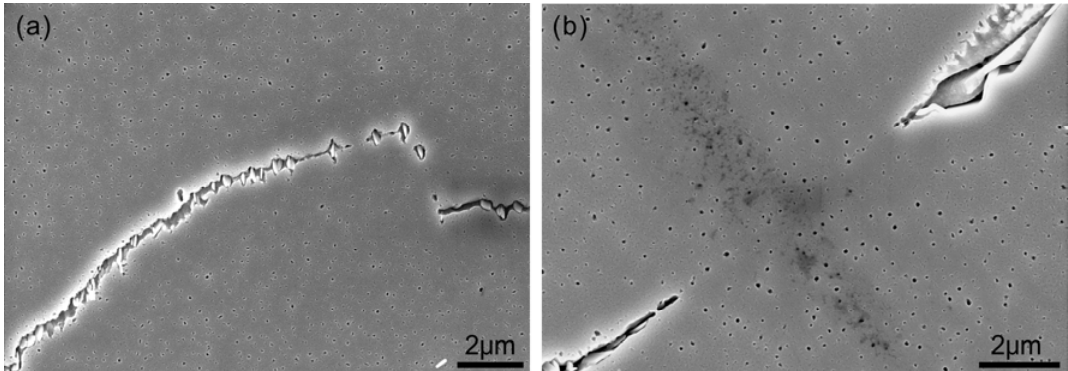
Figure 1. Typical SEM morphology of the precipitates: ( a ) granular and ( b ) lamellar.